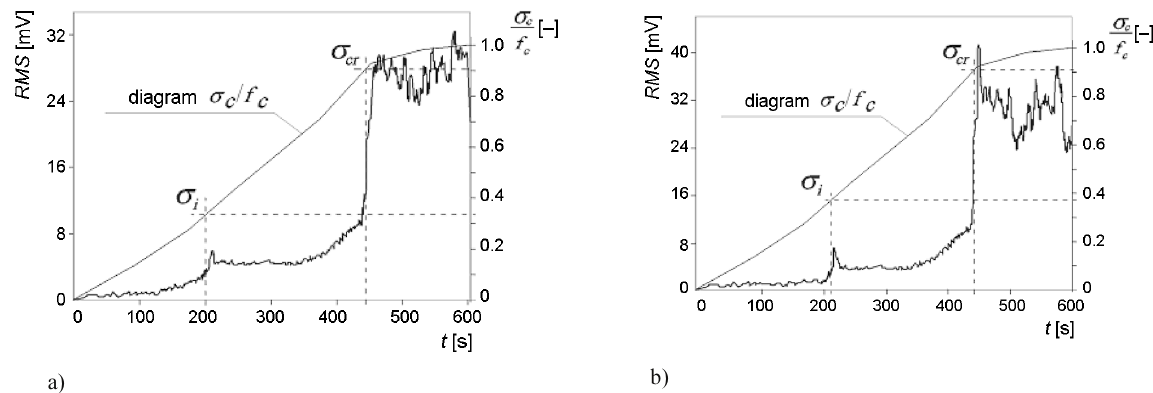
Fig. 10. RMS AE signal, referred to relative compressive stress σ c /f c , versus failure time for self-compacting